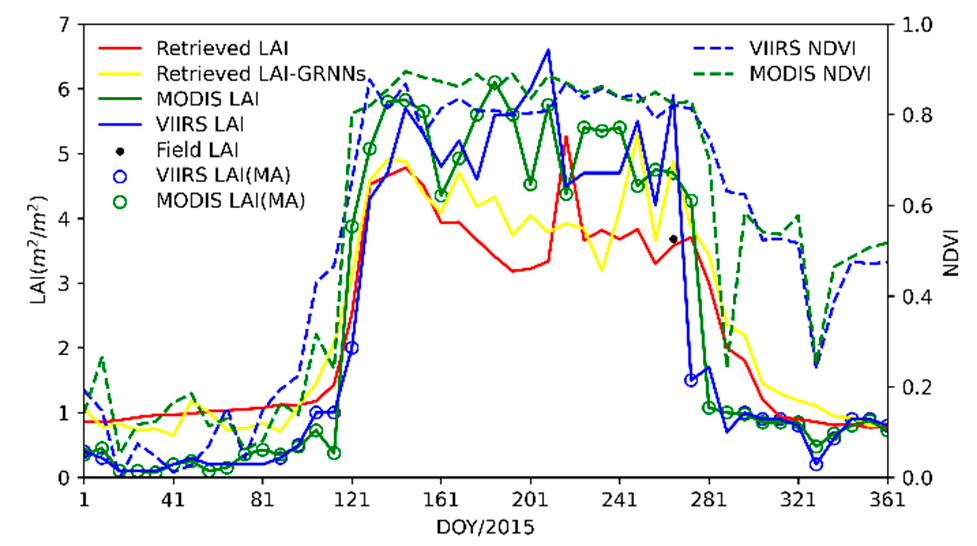
Figure 5. Temporal profiles of the retrieved LAI-TCA and the retrieved LAI-GRNN at the center pixel of the Collelongo site for 2015.